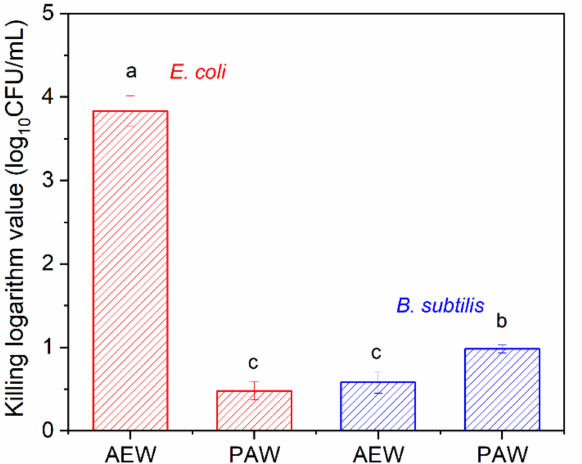
Figure 1. Sterilization effects of PAW and AEW on the bacterial suspension of E. coli and B. subtilis . Values with different lowercase letters above graph bars represent a significant difference ( p <